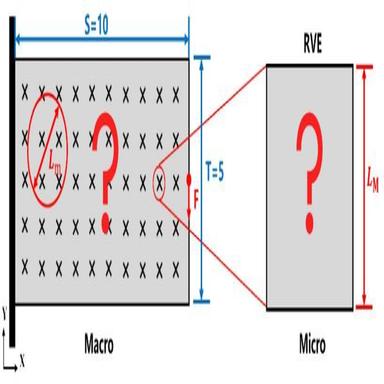
Diagram of cantilever beam and design domain of RVE.